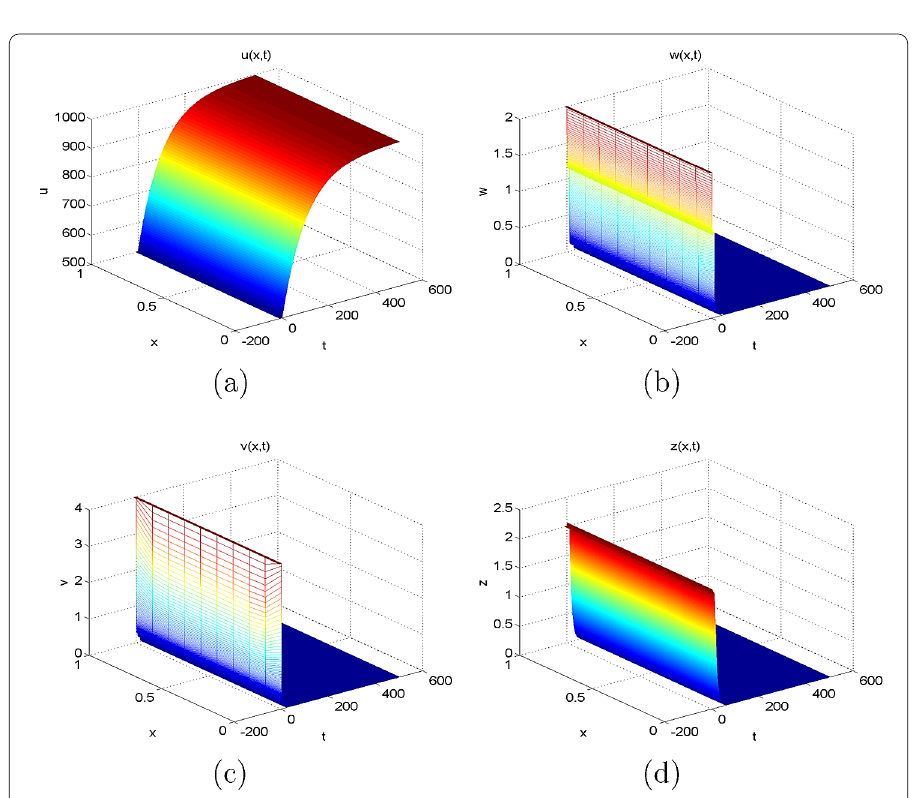
Figure 1 Taking β = 0.01, c = 0.1, q = 0.12, τ 1 = 10, τ 2 = 6, we have R 0 = 0.2066 < 1, the infection-free equilibrium E 0 (1000,0,0,0) is globally asymptotically